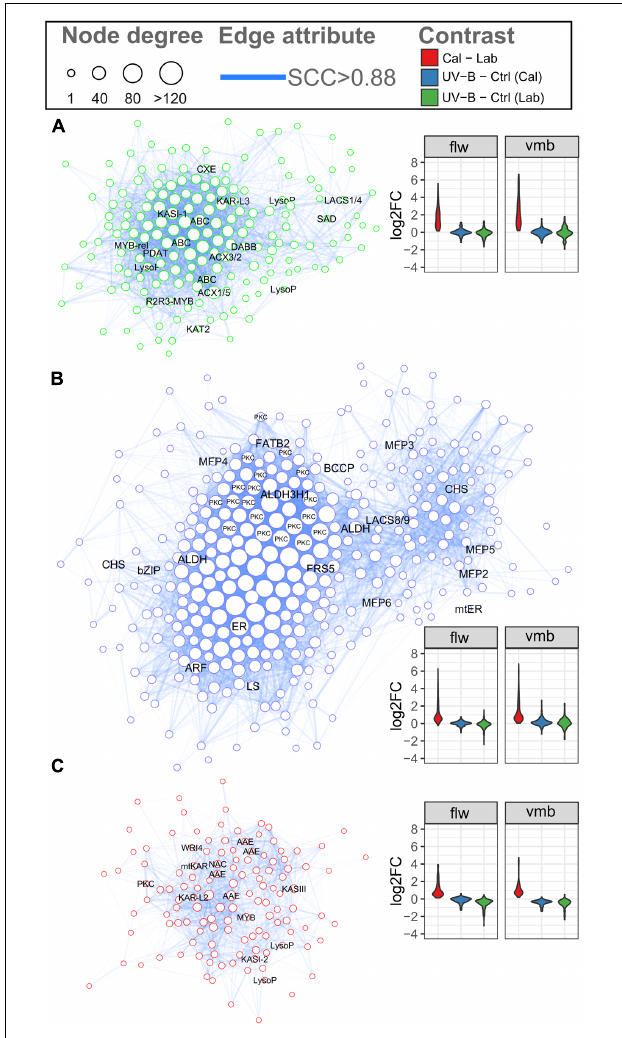
FIGURE 5 | Gene co-expression network of candidate submodules involved in biosynthesis and regulation of chiloglottone 1 production. The gene co-expression network depicts genes in submodule (A) 7, (B) 13, and (C) 18 that share co-regulation with FA biosynthesis and β -oxidation pathway transcripts. Nodes represent genes and sizes depict the number of connections between nodes. Edges (blue) represent significant correlation (SCC > 0.88) between genes. The estimated false-positive co-expressed gene pairs in the network is 0.1%. Gene names for FA biosynthesis and β -oxidation as well as other gene candidate are displayed on the corresponding nodes. Violin plots in each submodule depict the general gene expression dynamics in vmb (TC1, UVB1, and UVB2) and flower (TC2, UVB3, and UVB4) comparisons of respective submodule. See Supplementary Figure 5 (or Supplementary Data 3 ) for